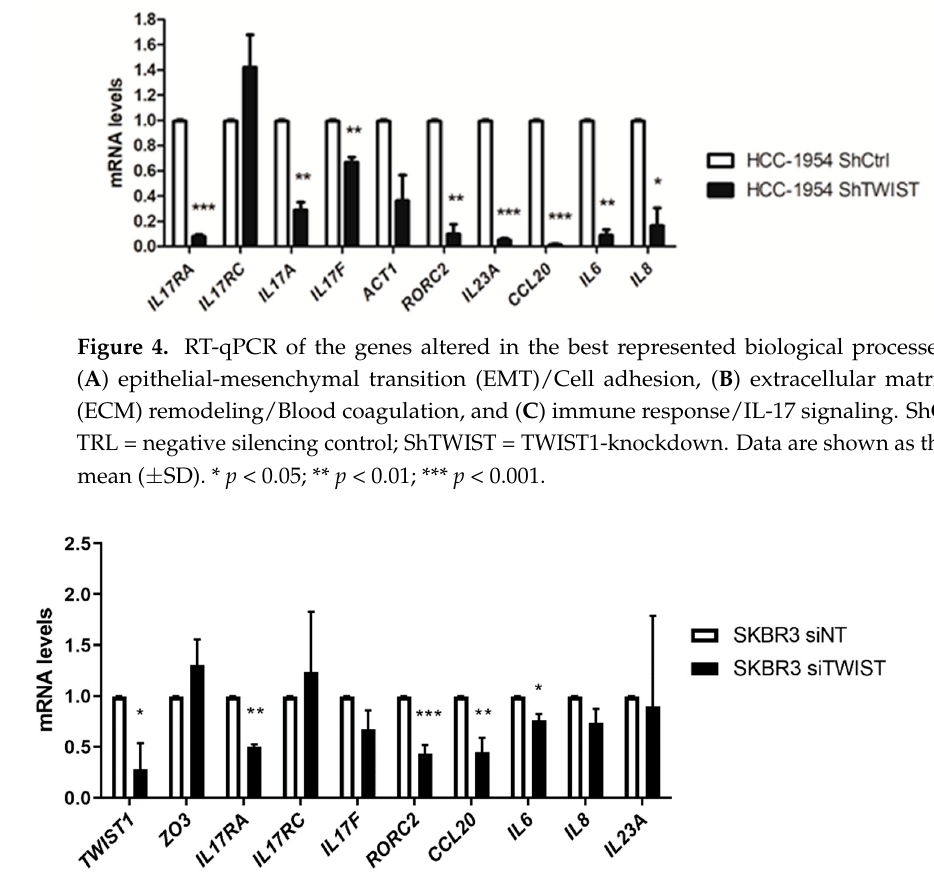
Figure 6. Evaluation of IL-17 signaling in TWIST1-knockdown BC cells compared to control cells. ( A ) Protein levels of Act1 and IL-17RA in ShCTRL and ShTWIST cells. GAPDH was used to ensure that the same sample amounts were loaded for immunoblotting. Densitometric analysis was done using ImageJ software. ( B ) Levels of secreted IL-6 and IL-8 proteins in the supernatant of ShCTRL and ShTWIST cells. Data are shown as the mean (±SD). * p < 0.05